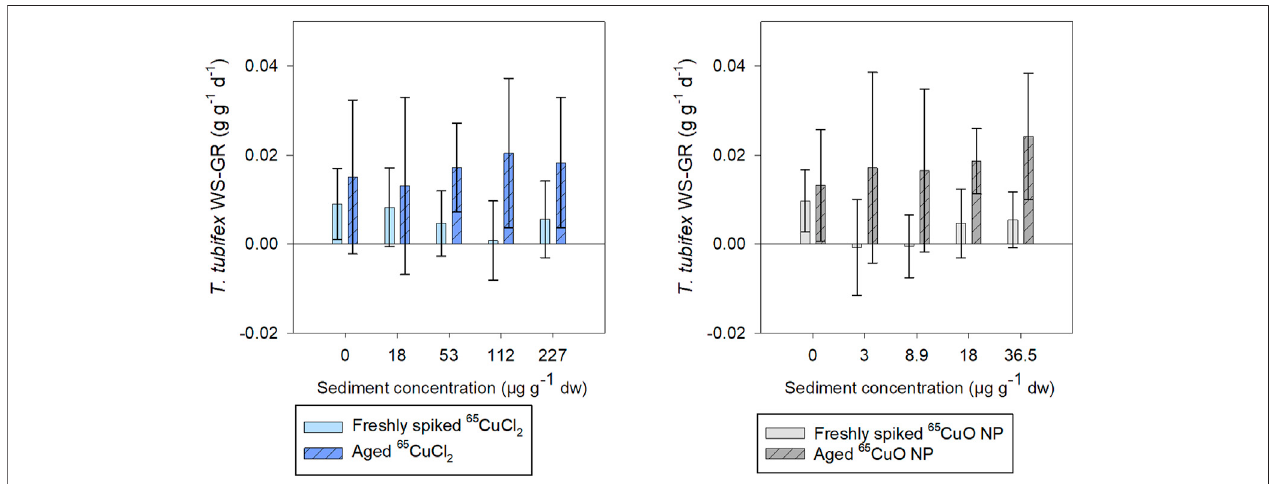
FIGURE 4 | T. tubifex weight-speci fi c growth rate (WS-GR) during exposure in freshly spiked sediment (full bars) or aged sediment (scratched bars). Worms were exposed in sediment with 65 CuCl 2 [blue, (A) ] or 65 CuO NPs [gray, (B) ] at fi ve different concentrations for 28 days. Bars represent the mean WS-GR ± SD, n (cid:1) 10.